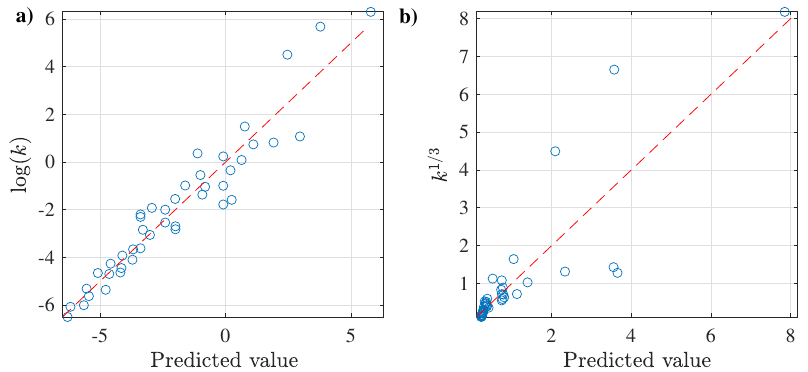
Figure 11. Prediction results for the XG dataset of ( a ) polynomial regression in Figure 10 and ( b ) the best power combined